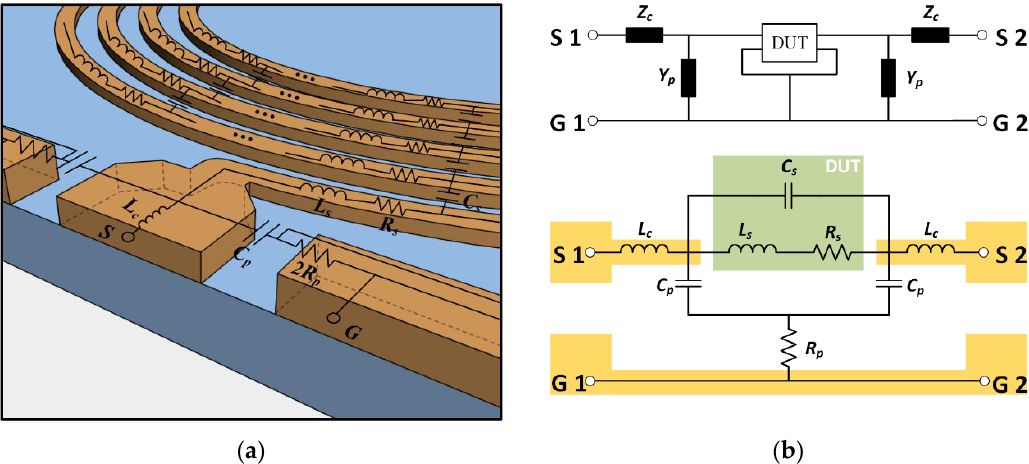
Figure 6. ( a ) Schematic diagram of on-chip spiral inductor with GSG pads and its ( b ) topology and equivalent physical models.